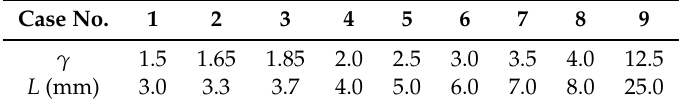
Table 1. Information about bubble’s position in the initial flow field under each case.